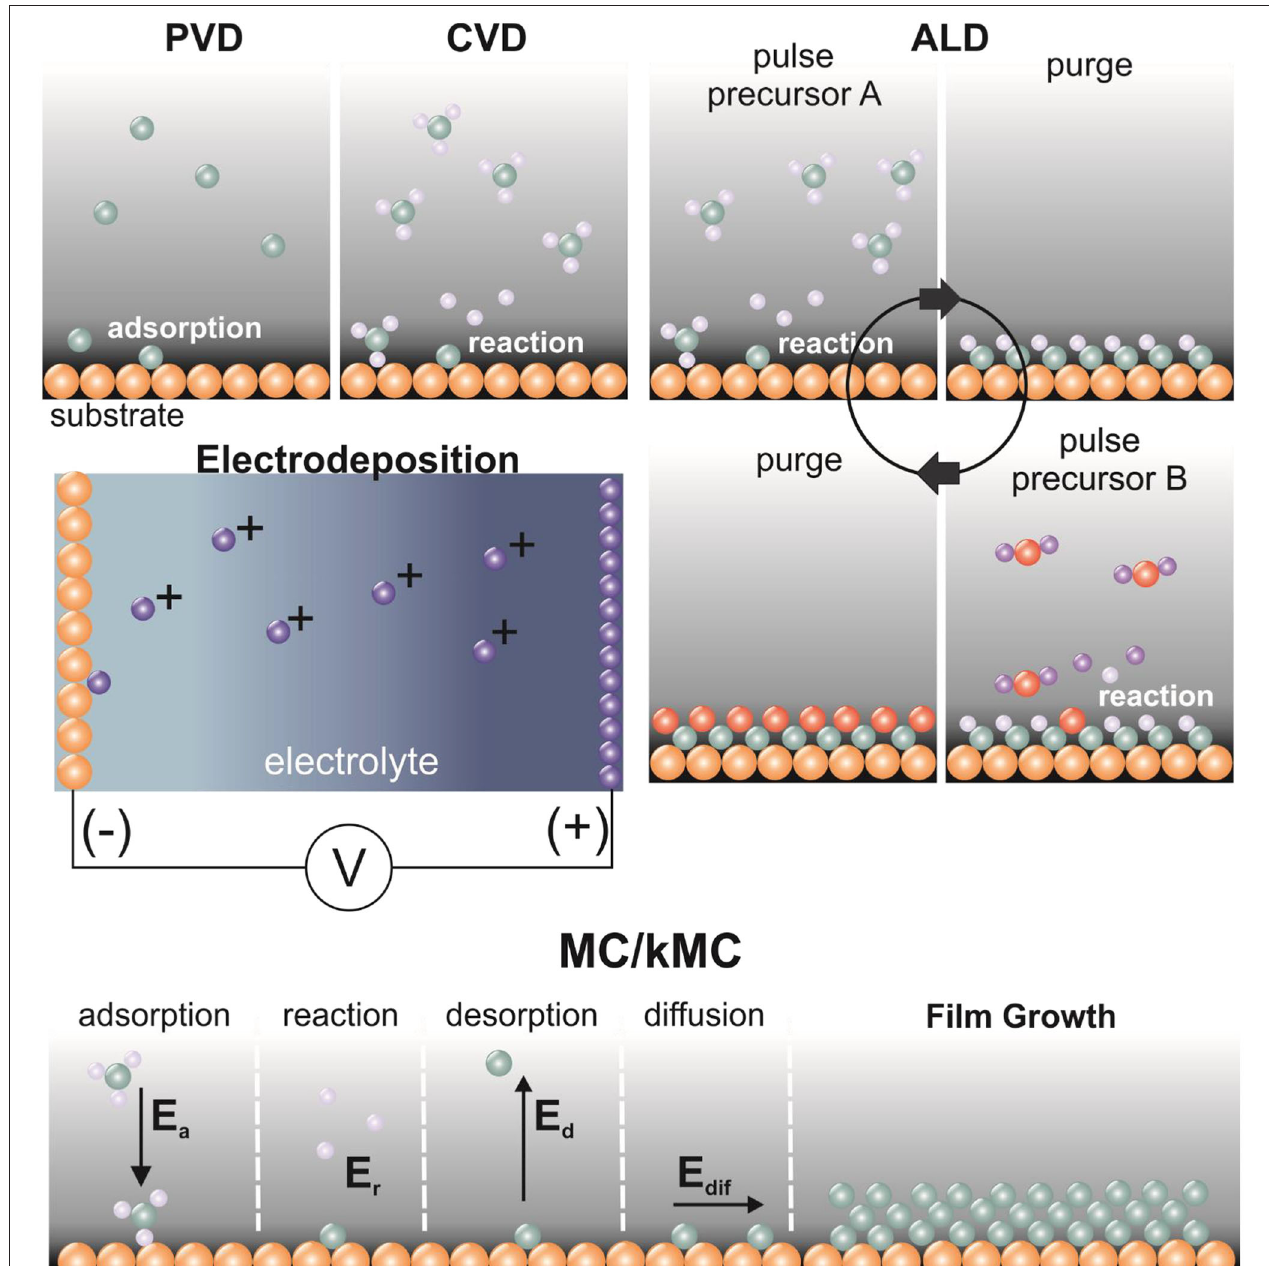
FIGURE 1 | Schematic representation at the molecular level of the basic principles in deposition processes. In PVD, particles are adsorbed in the substrate. In CVD, particles (here an arbitrary molecule is shown) react on the substrate surface to grow the film. In ALD, multiple precursors (here A and B) are injected into the reactor though pulses in a cyclic way of pulses-purges and grow the film through self-limiting surface reactions. In electrodeposition, the voltage (V) is applied causing the particles from the cathode to move to the anode through an electrolyte where the film is grown through adsorption or surface reactions. In MC/kMC methods, an activation energy is assigned to each event. In MC, if the event leads the system to a smaller energy, it is accepted unconditionally. If not, it is selected with a probability according to Equation (2). In kMC, an event is selected from a predefined rate catalog containing all possible rates and performed unconditionally. Then the system evolves in time according to Equation (4). The four basic events - adsorption, reaction, desorption and diffusion- whose combination can describe a deposition process, with their activation energies, E a , E r , E d , and E dif are shown.